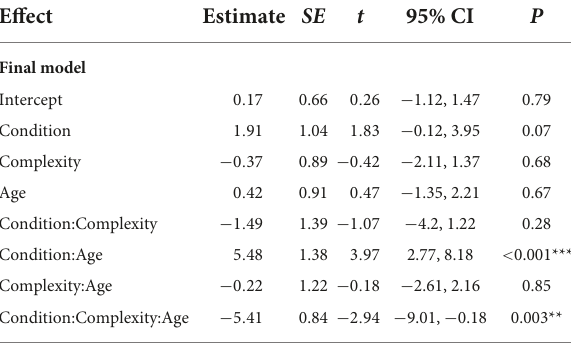
TABLE 5 Fixed effects from the LME model of rule learning β